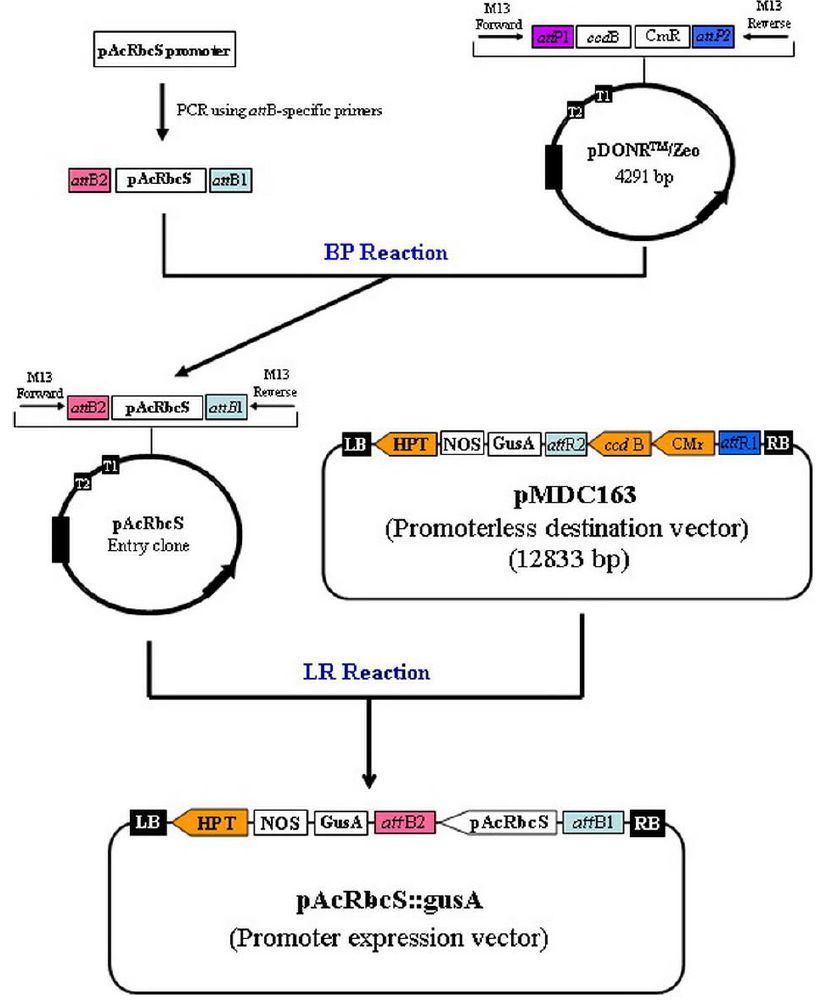
Figure 6. Schematic diagram showing the construction of pAcRbcS::gusA